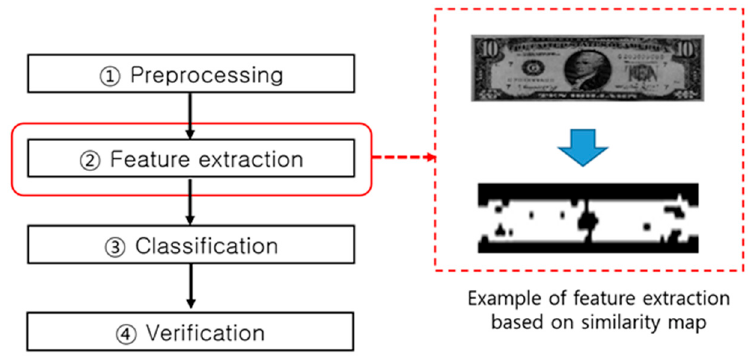
Figure 7. Feature extraction in the banknote recognition process flow.